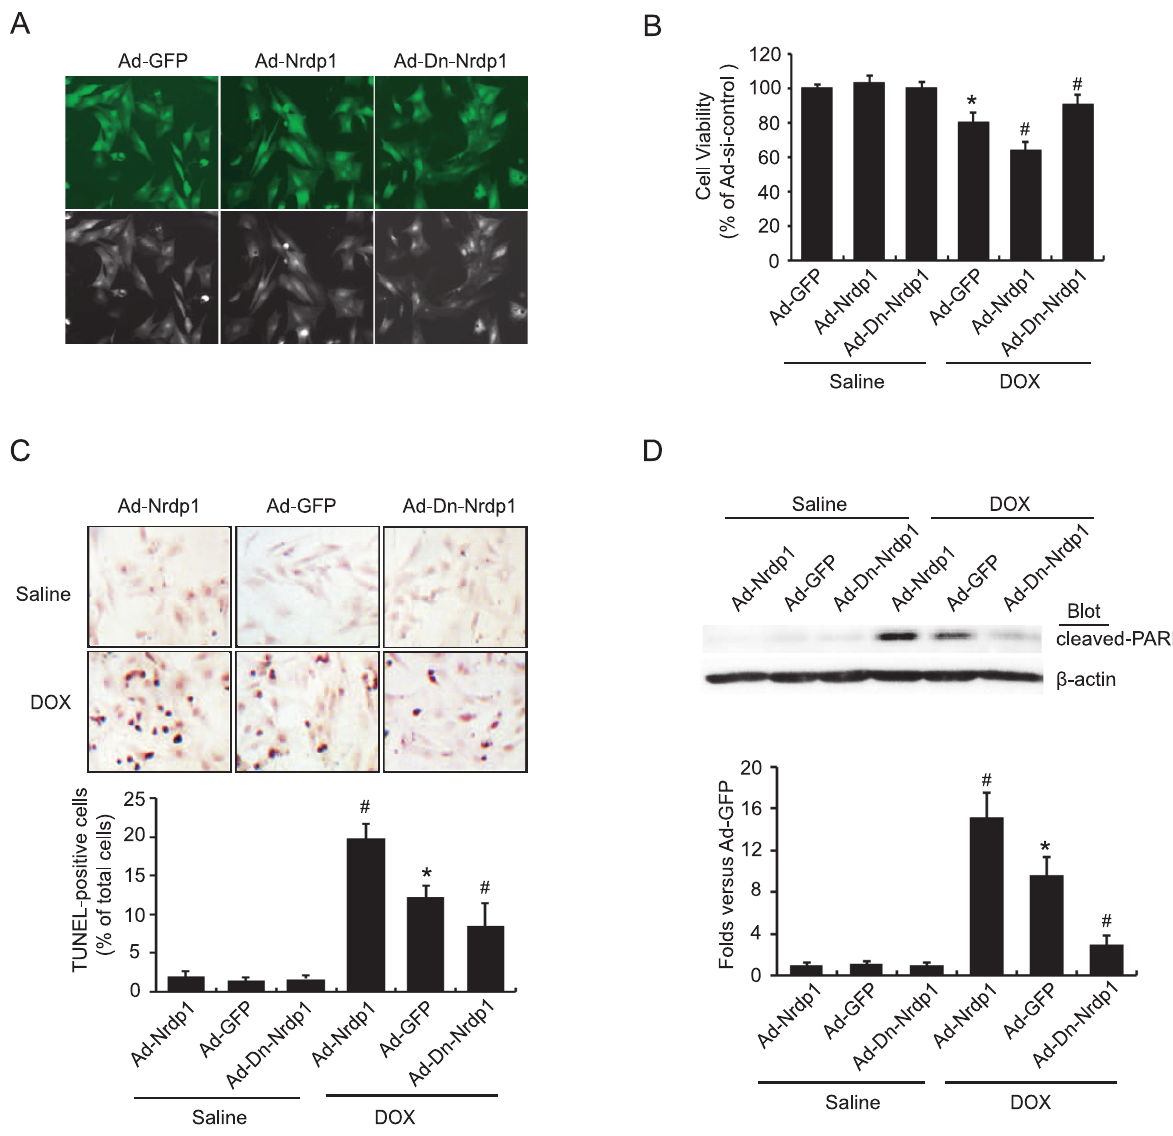
Figure 2. Effects of Nrdp1 on DOX-induced cell death in rat neonatal cardiomyocytes. A. The infection efficiency of cardiomyocytes with Ad-GFP, Ad- Nrdp1 and Ad-Dn- Nrdp1 was visualized by green fluorescent protein (GFP) 24 hours later on fluorescence microscopy. (magnification, 6 400). B. Cardiomyocytes were infected by with Ad-GFP, Ad- Nrdp1 or Ad-Dn- Nrdp1 and then treated with 5 m M DOX for 24 hr. Cell viability was measured by trypan blue exclusion assay. C. Apoptosis was detected by TUNEL assay. A representative field is shown for each condition (top panels). Quantitative analysis of TUNEL-positive cells from 3 independent experiments (bottom panels, magnification, 6 200). D. Cardiomyocytes were infected and treated with DOX as in A. Western blot analysis of expression of cleaved poly ADP-ribose polymerase (PARP) protein (top panel). Quantitative analysis is in the bottom panel. * P , 0.01 vs. Ad-GFP. # P , 0.05 vs. Ad-GFP + DOX. Results are expressed as means 6 SEM (n=3).